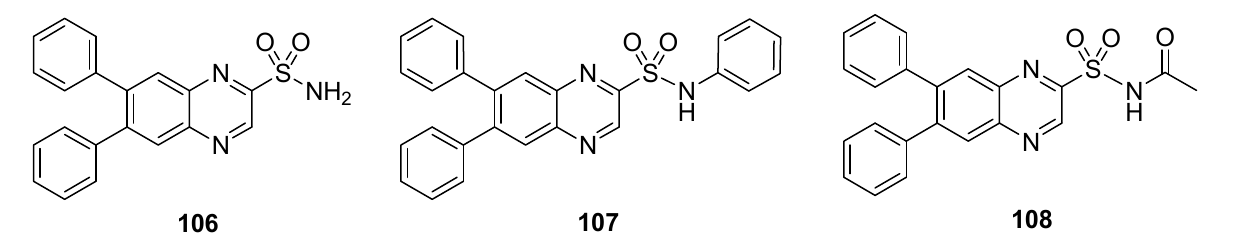
Figure 16. Substituted quinaxoline sulfonamide derivatives 106–108.